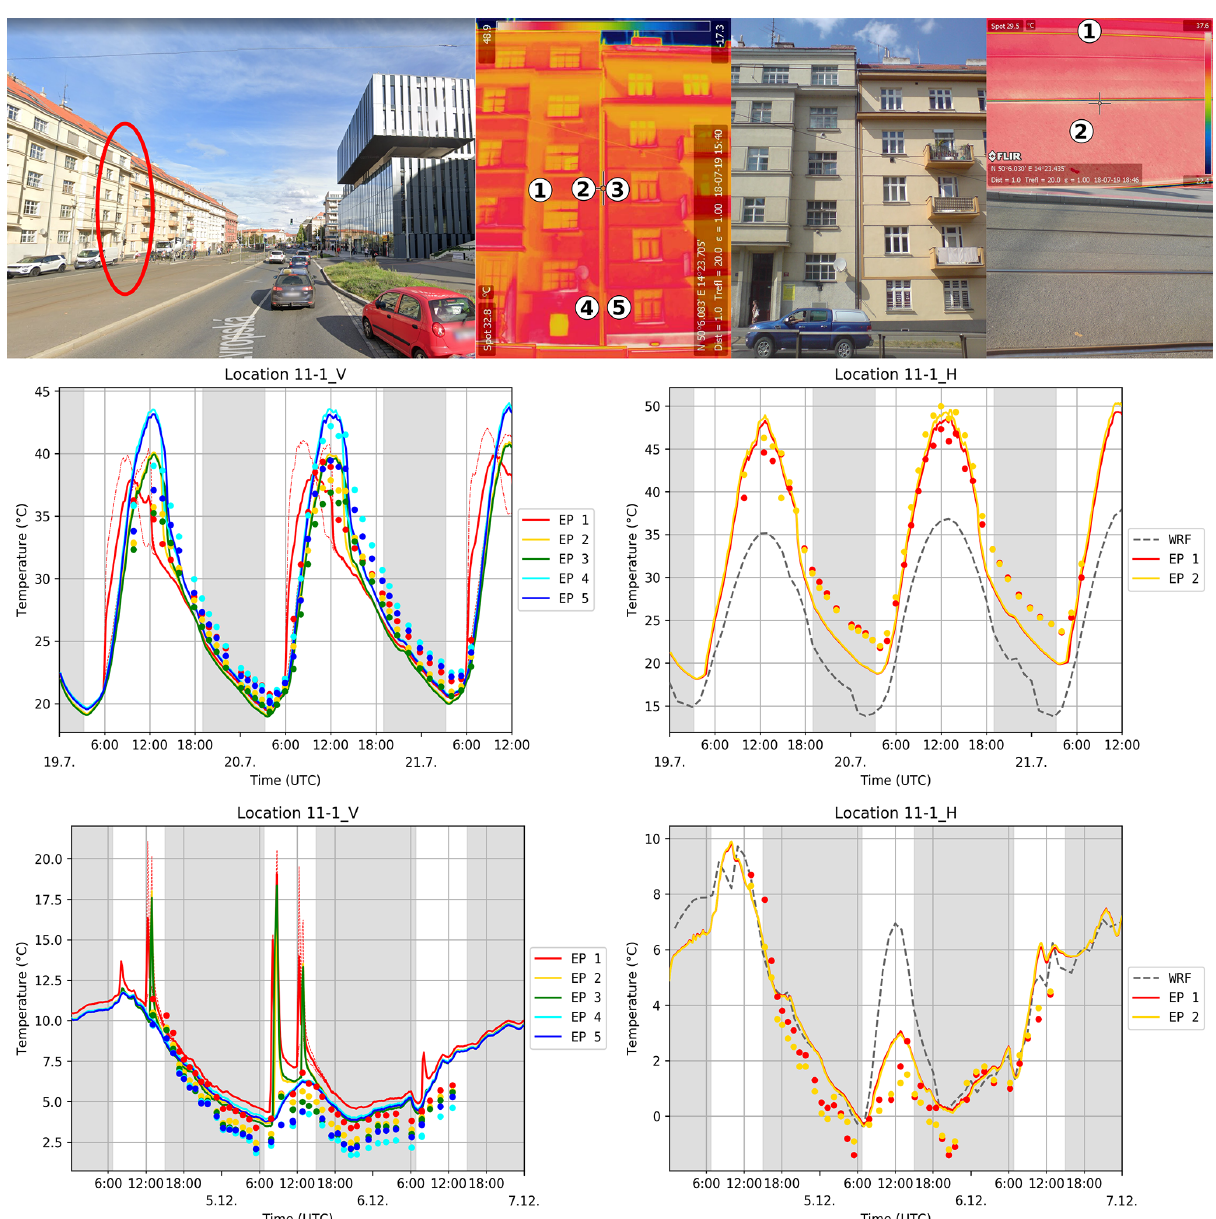
Figure 11. Observation location 11-1: the upper row shows the observation location and IR and RGB photos with placement of the evaluation points; the graphs show observed (dots) and modelled (lines) surface temperature for wall (left panels) and ground (right panels) for particular evaluation points (EP) for the summer e2 (middle panels) and winter e3 (bottom panels) episodes. The modelled values come from the child PALM domain, and the dotted and dashed lines represent the modelled temperature for the left and right grid faces (see Sect. 5.1.1). The grey dashed line shows the corresponding WRF skin layer temperature for horizontal surfaces. The grey areas denote night-time. The image in the left panel was sourced from © Google Maps